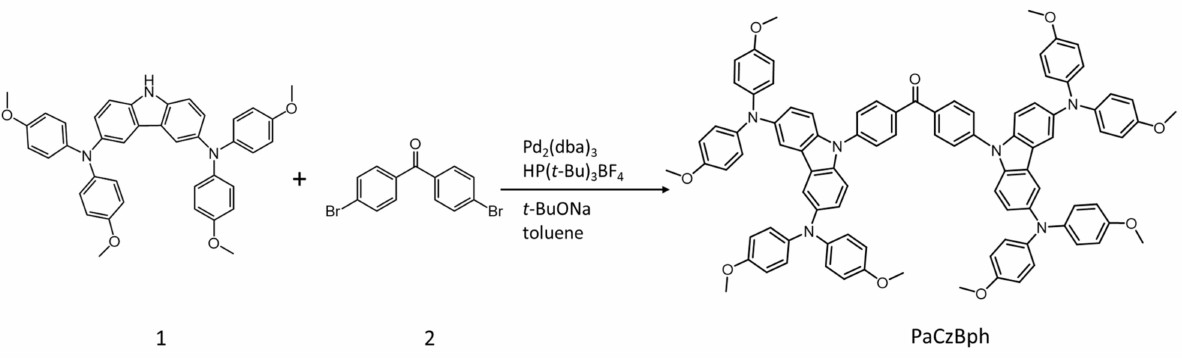
Figure 16. Synthesis of PaCzBph. Reprinted from [78] with permission from